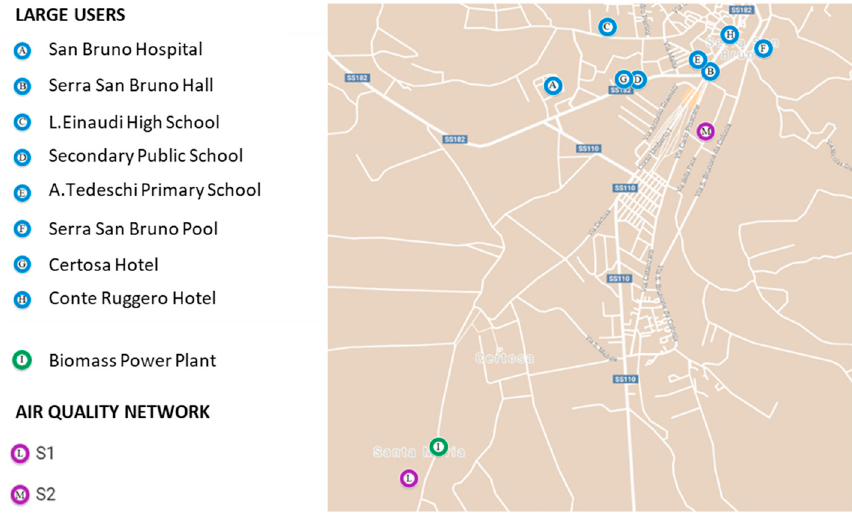
Figure 2. Large users and air quality monitoring devices located in Serra San Bruno.